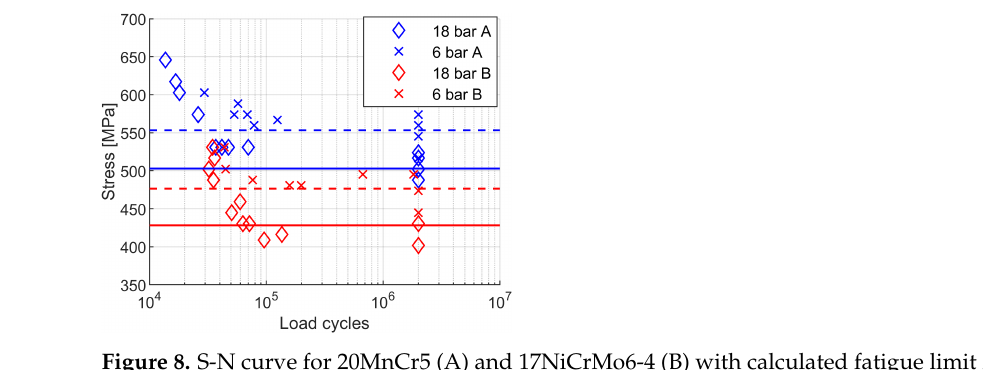
Figure 8. S-N curve for 20MnCr5 (A) and 17NiCrMo6-4 (B) with calculated fatigue limit for HPGQ with 18 bar Direct (–) and 6 bar Stop